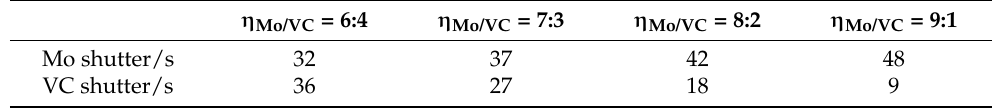
Table 1. The opening time of the Mo and VC